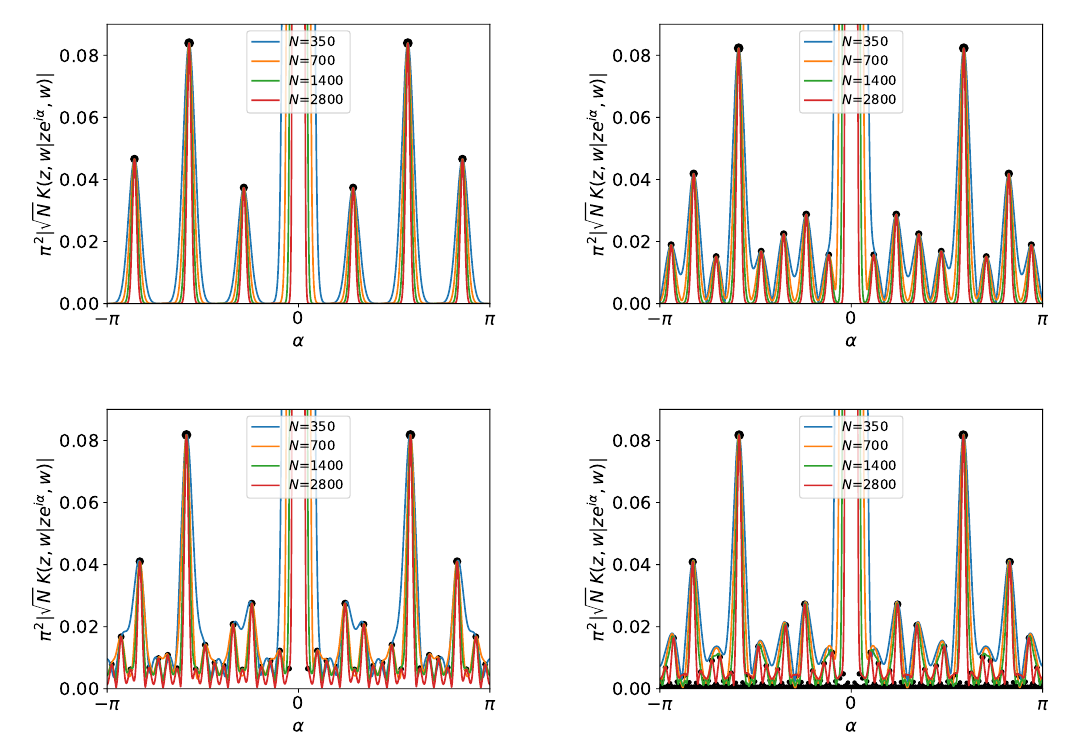
(cid:112) N | K ( x , x (cid:48) ) | given by (18), for points (19) on Figure 9: The rescaled correlator the slice β = 0 of an edge torus at θ = π/ 2. Black dots denote the maxima of correlations predicted by the limiting function (24). The four panels have anisotropy (cid:112) ratios providing different rational approximations of 2: from left to right, ∆ = 7 / 5 (cid:112) and ∆ = 17 / 12 in the top panels, while ∆ = 41 / 29 and ∆ = 2 in the bottom panels. Each plot displays several values of N ; the largest corresponds to over 2 million particles. The correlator does not seem to converge to a smooth function in the thermodynamic limit N → ∞ ; it becomes instead more ragged at shorter distance